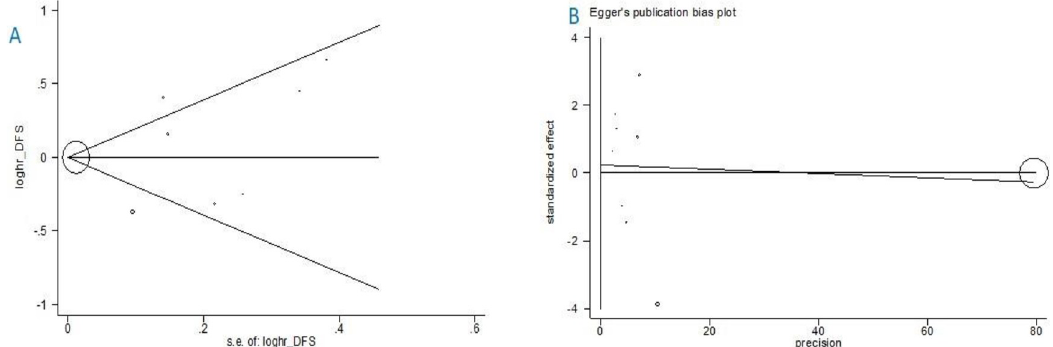
Fig 6. ( A ) Begg’s funnel plot with pseudo 95% confidence limits. ( B ): Egger’s publication bias plot.